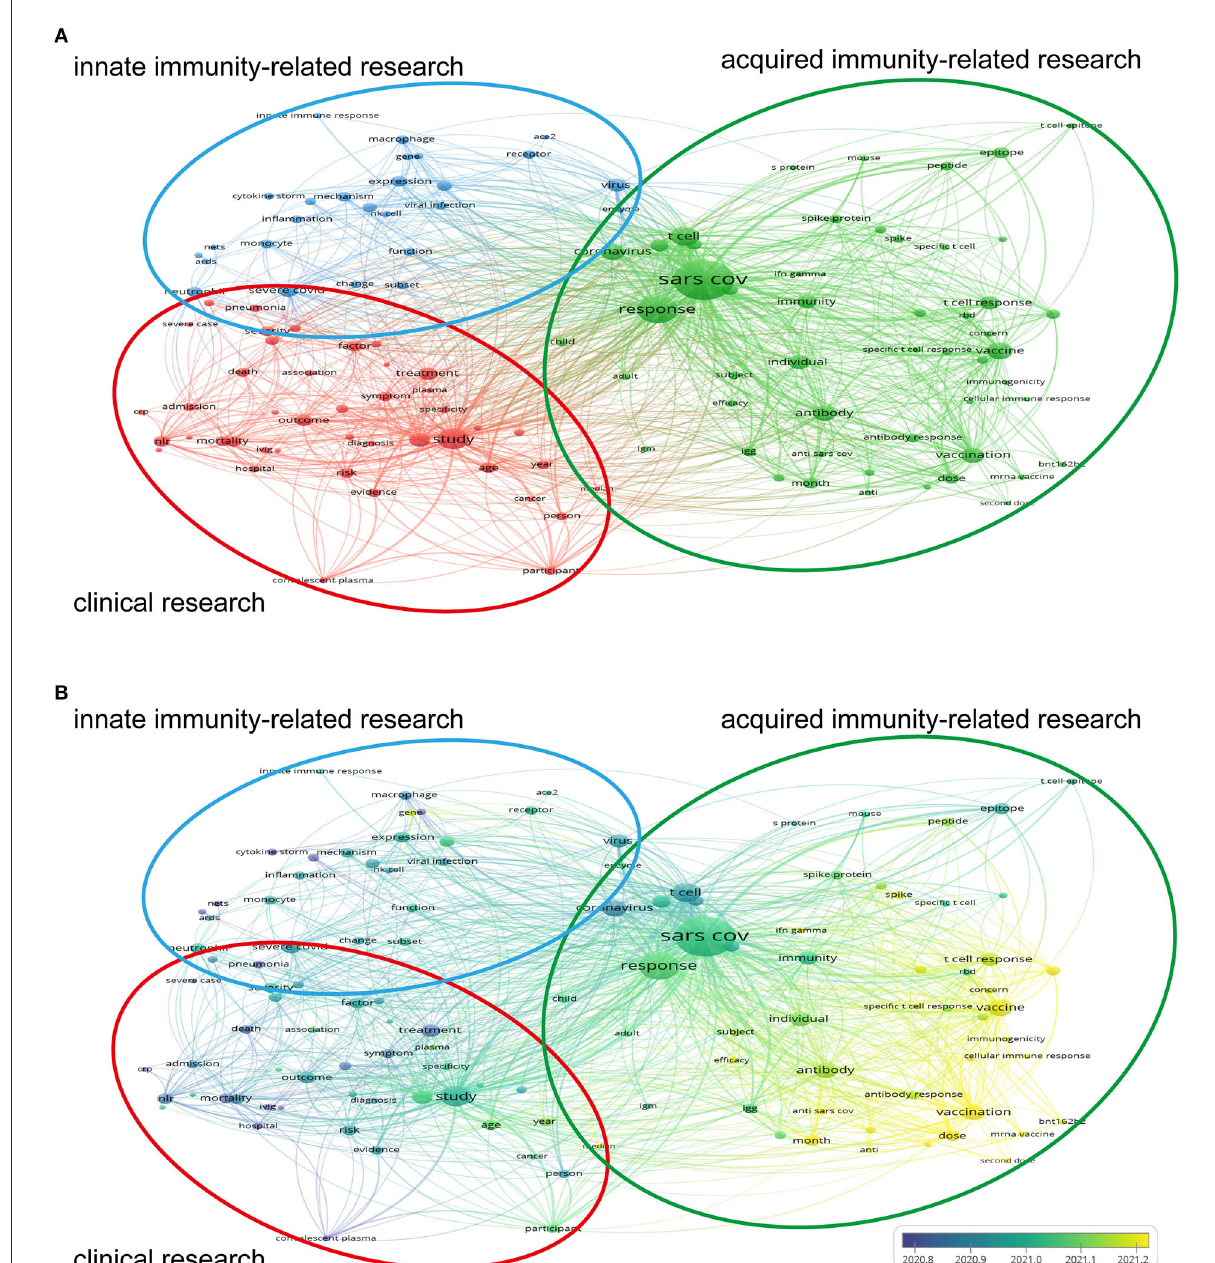
FIGURE4 Cluster analysis diagram of research hotspots. Keywords that appeared at least 85 times in titles and abstracts were analyzed by VOSviewer software. The larger the circle of the keyword, the more frequently it appeared. The co-occurrence times of two keywords determined the distance between them. (A) The keywords were classified into three clusters: clinical research (red), acquired immunity-related research (green), and innate immunity-related research (blue). (B) Keywords were colored in chronological order. Purple keywords were the early-emerging ones, whereas keywords in yellow appeared more